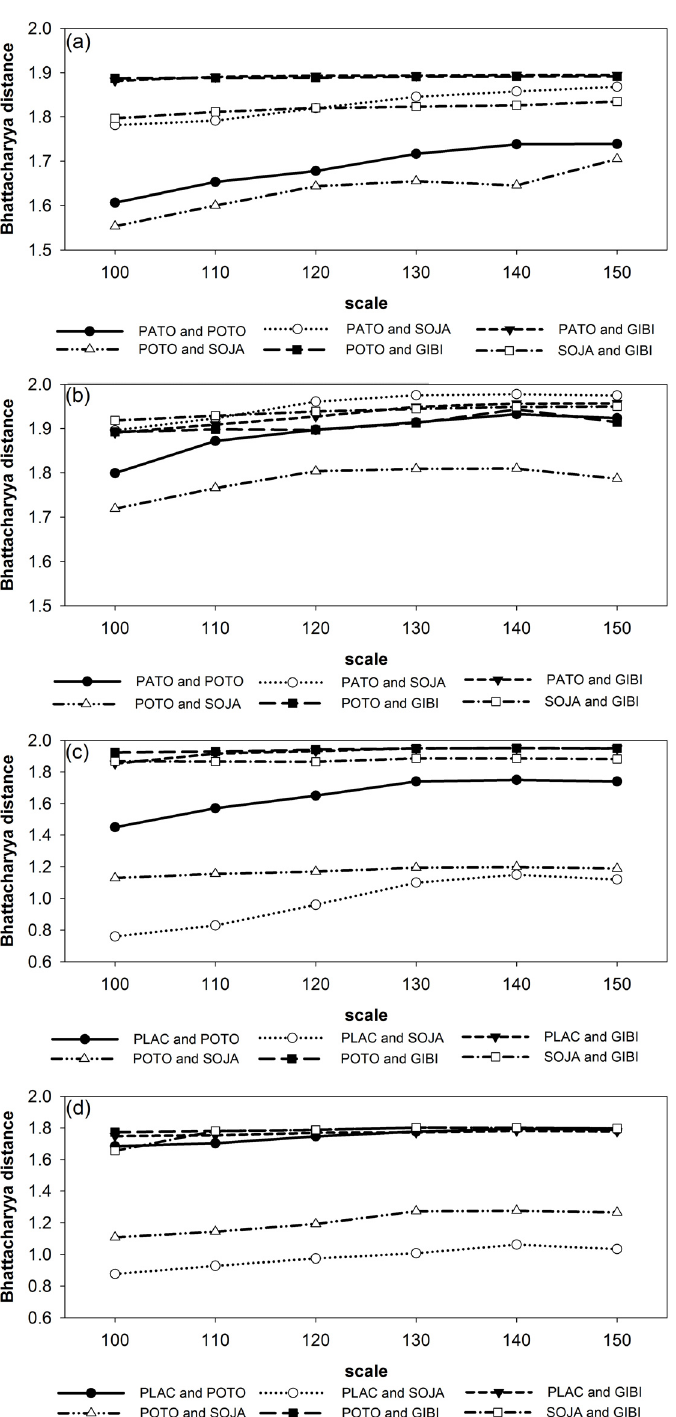
Figure 4. BD values between six pairs of tree species at image segmentation scales from 100 to 150. ( a ) BD values from WV2 image at CNU; ( b ) BD values from WV3 image at CNU; ( c ) BD values from WV2 image at BNU; ( d ) BD values from WV3 image at BNU.